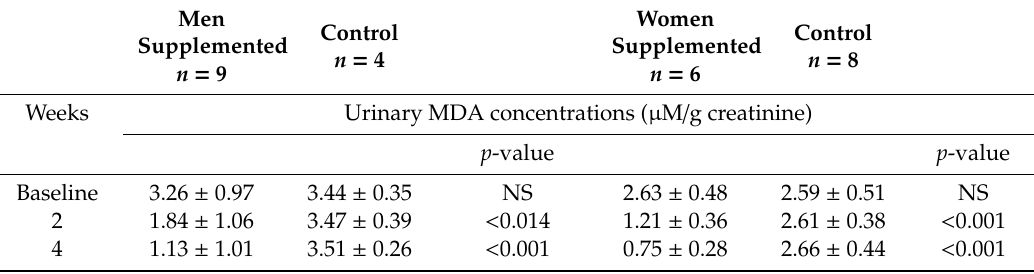
Table 6. Urinary MDA concentrations in men of the supplemented and control group and women of the supplemented and control group, before, during, and after 4 weeks of